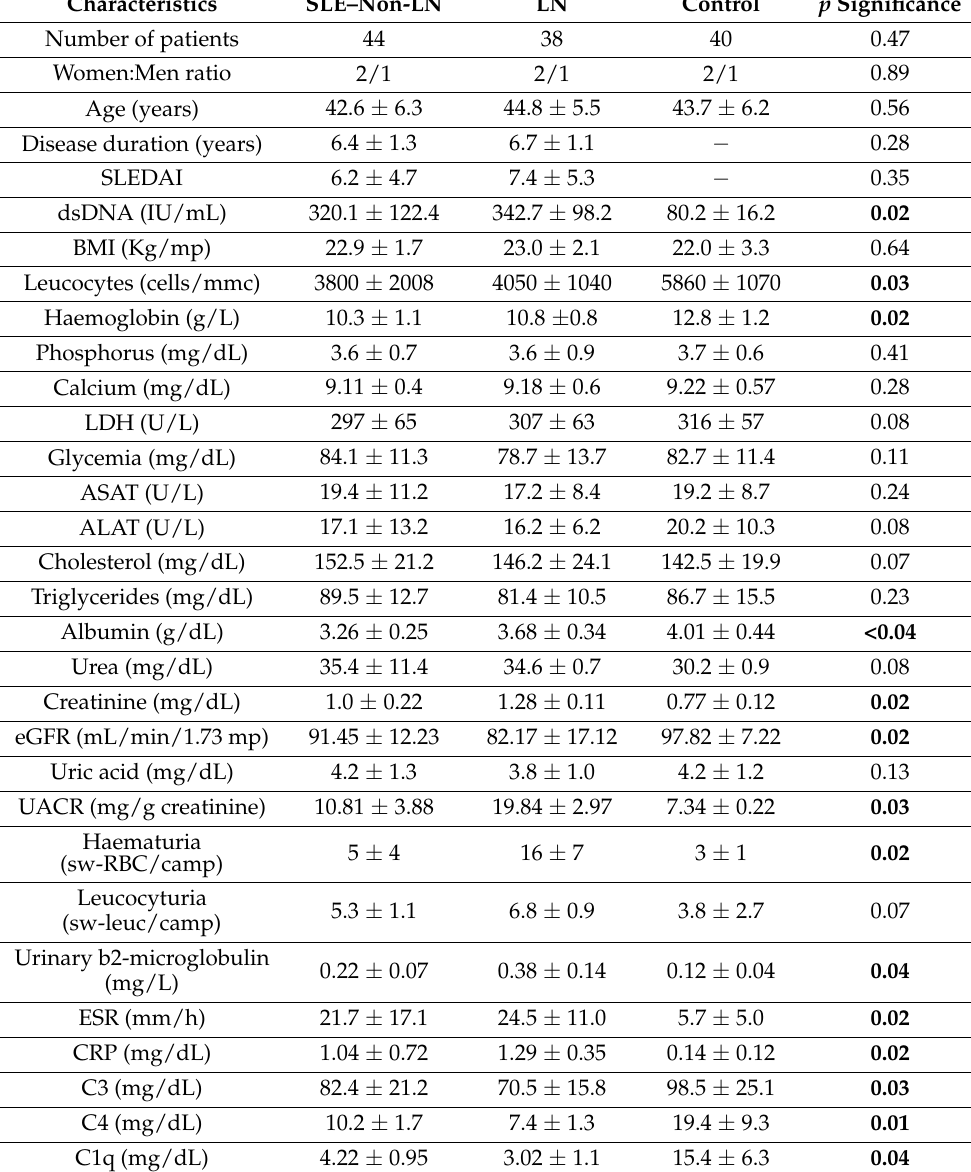
Table 1. Patients’